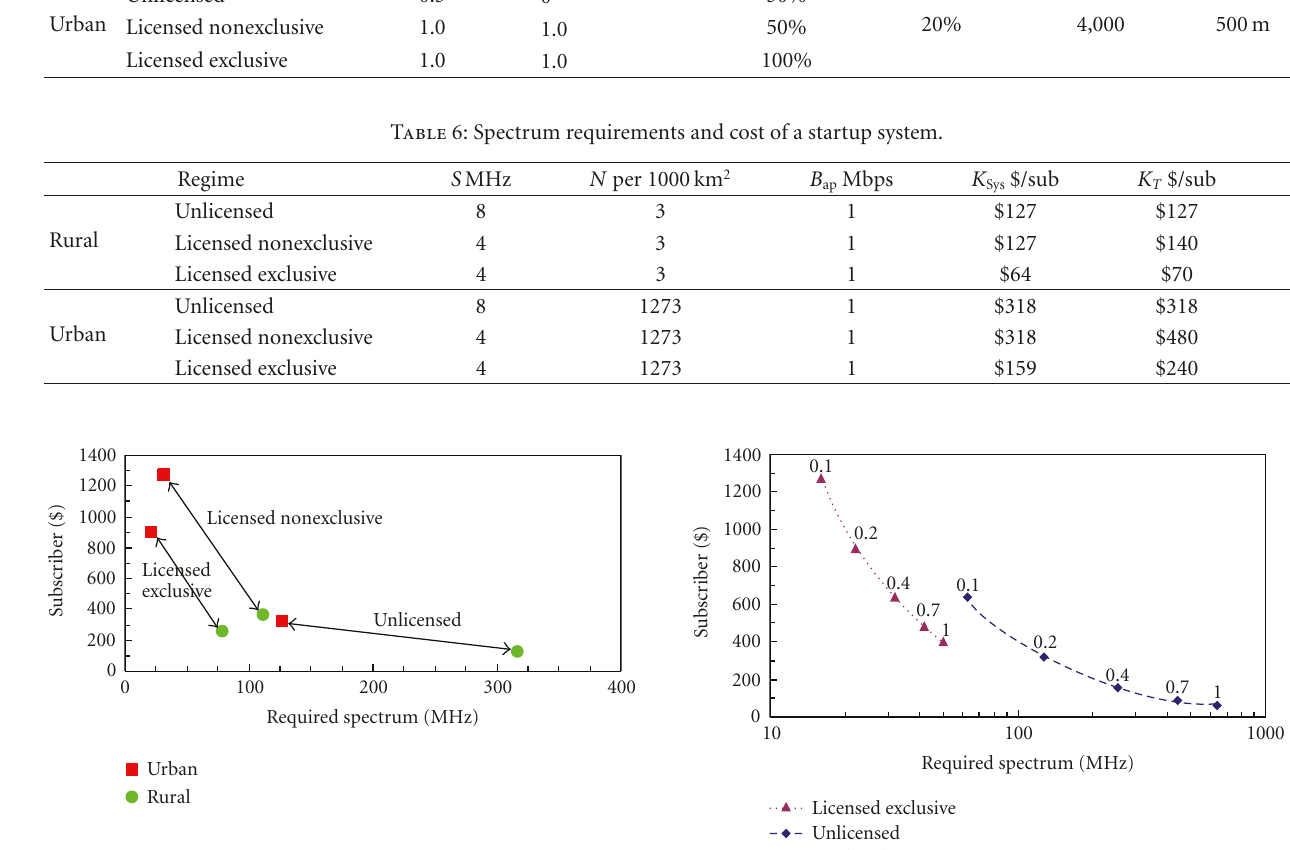
Figure 4: Required spectrum and cost per subscriber in the six regimes.